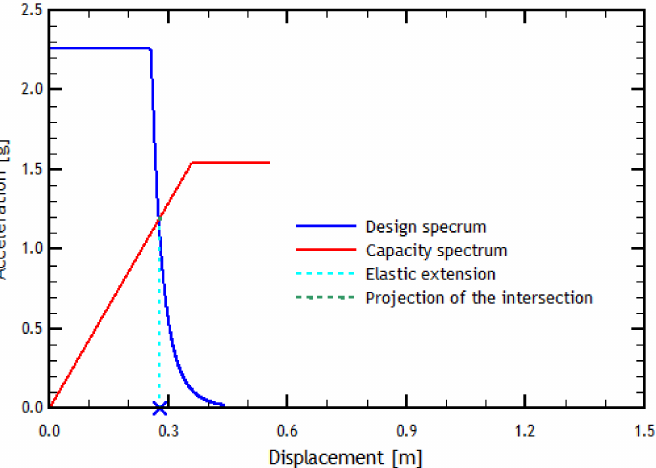
Figure 10. Determination of the performance point using the N2 method in the transverse direction. The blue cross represents the Performance Point displacement.